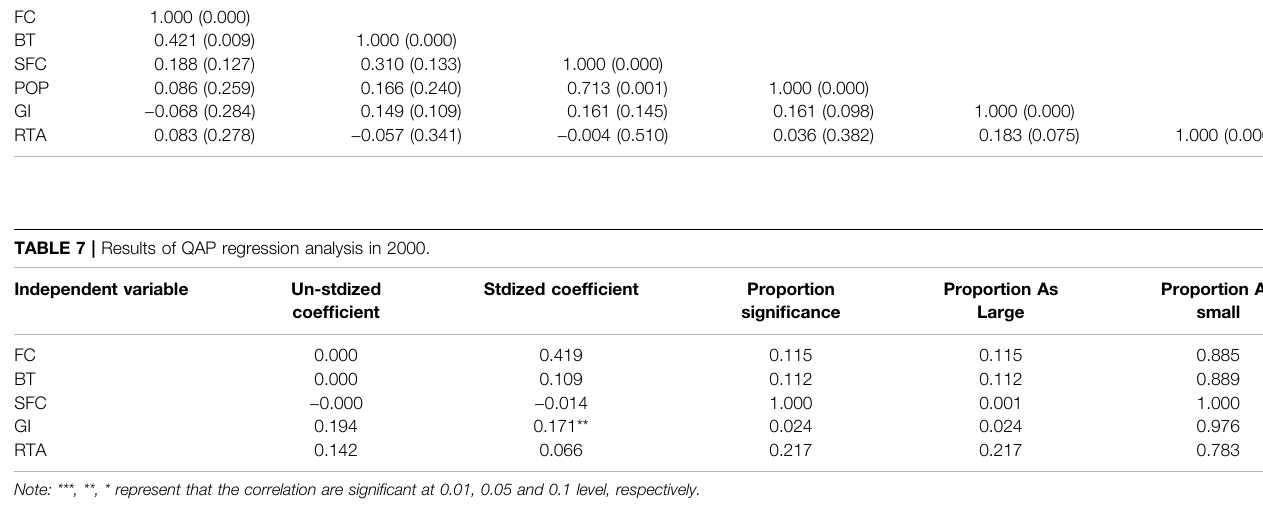
TABLE 6 | QAP correlation analysis between explanatory variables. FC BT SFC POP GI